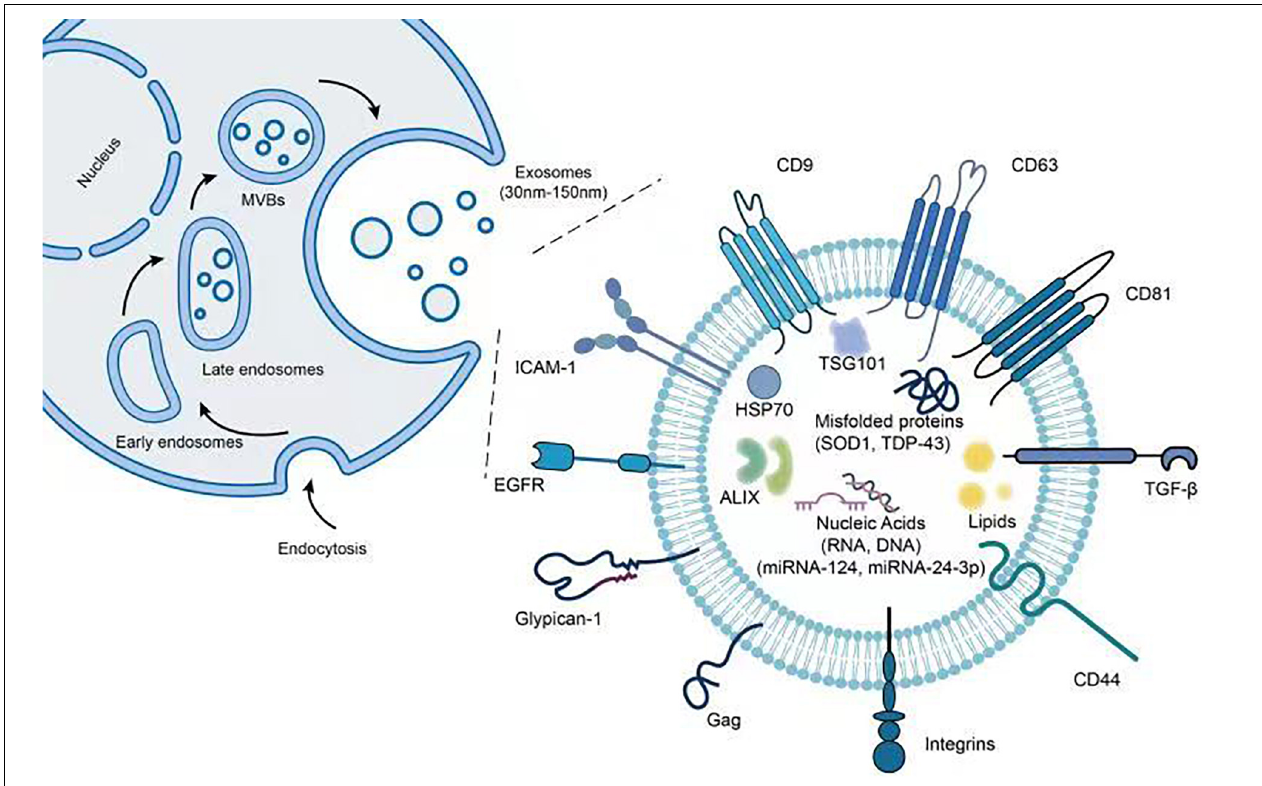
FIGURE 1 | Illustration of exosome structure and associated proteins and miRNAs. The figure demonstrates the steps of exosome biogenesis as well as potential biomolecules found both inside as well as on the surface of